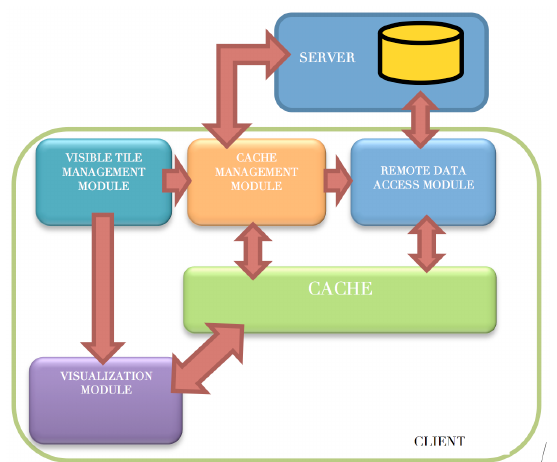
Figure 5 System architecture of the proposed approach